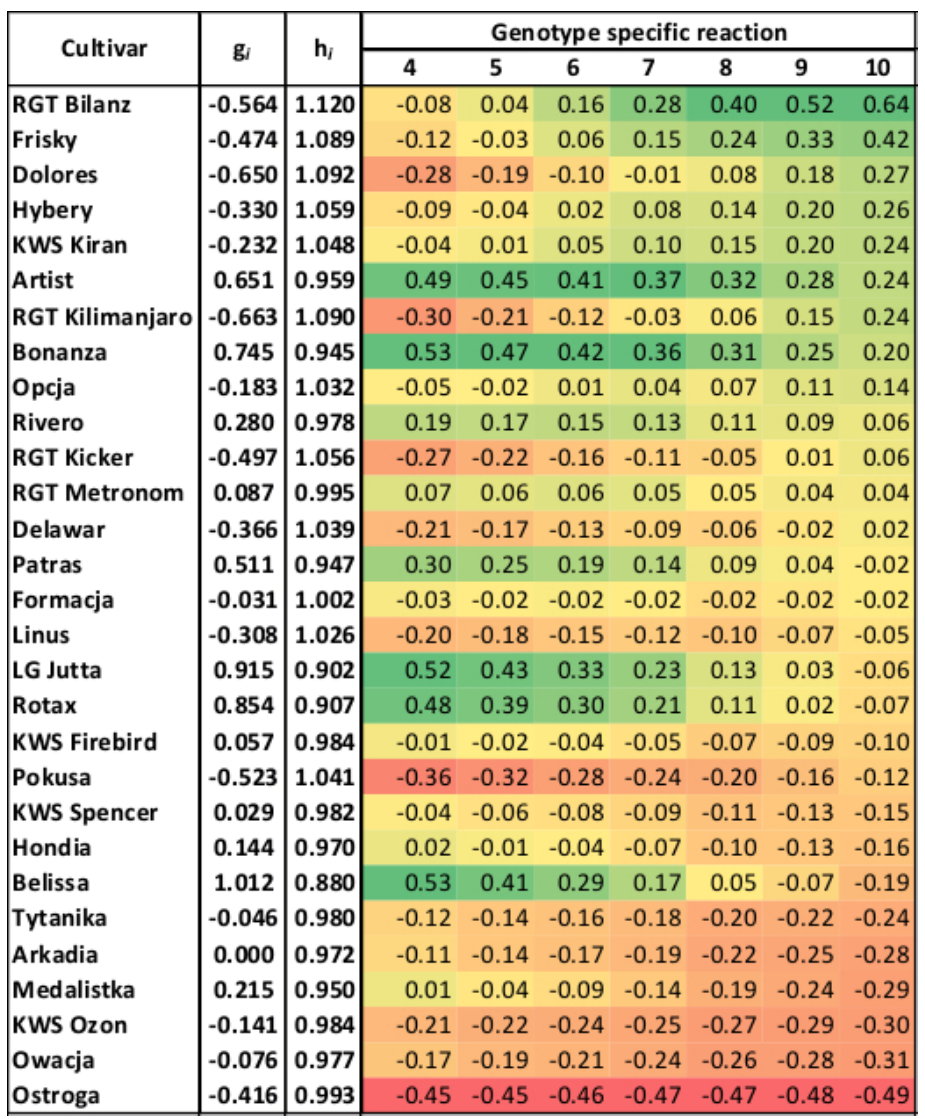
Figure 3. Genotype specific reaction (GSR) in environments of determined productivity ranging from 4 to 10 t / ha. The row position in the figure indicates relative productivity of a particular cultivar in comparison to the other cultivars. The intensity of shading informs the type and degree of winter wheat cultivar adaptation to environment productivity. The green color indicates high and positive reaction of cultivar while red means low and negative reaction in the environment of the specified